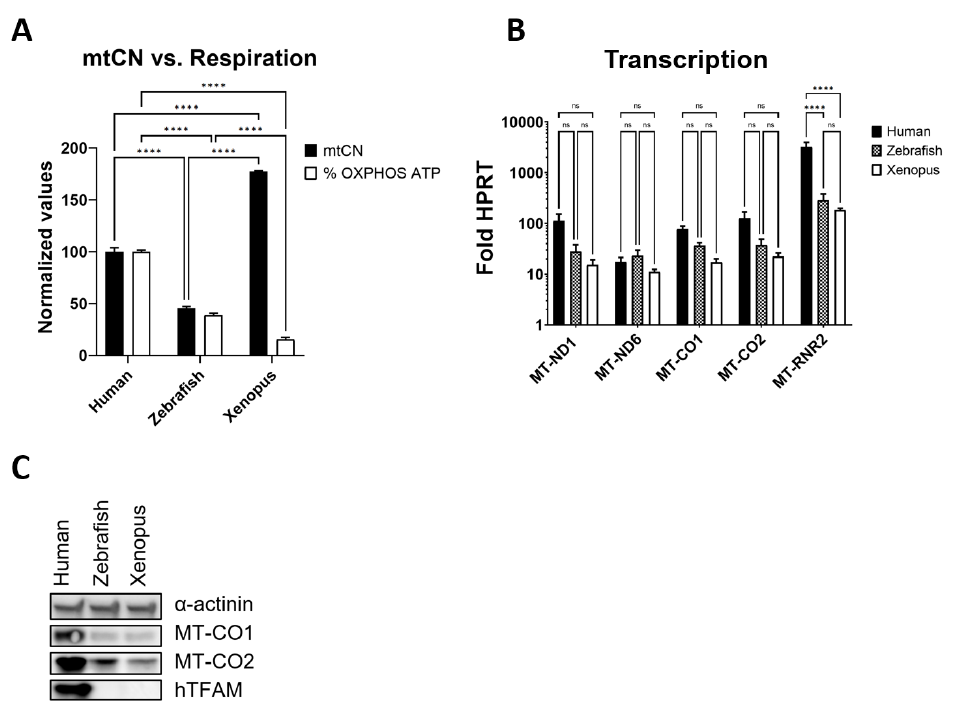
Figure 7. Separation of mtDNA replication and OXPHOS in cells expressing frog TFAM. ( A ) mtCN and respiration in cells expressing TFAM from Homo sapiens , Xenopus leavis , or zebrafish. Values have been normalized to those in cells expressing human TFAM, which were assigned 100%. Results are representative of at least two biological replicas with at least three technical replicas per biological replica. **** p < 0.0001. Two-way ANOVA with Tukey’s multiple comparisons test. ( B ) mitochondrial transcription analysis in cells expressing human, frog, or zebrafish TFAM. Results are an average of three biological experiments with at least three technical replicates per experiment. **** p < 0.0001. Two-way ANOVA with Tukey’s multiple comparisons test. ( C ) Western blotting analysis of expression of hTFAM and mtDNA-encoded MT-CO1 and